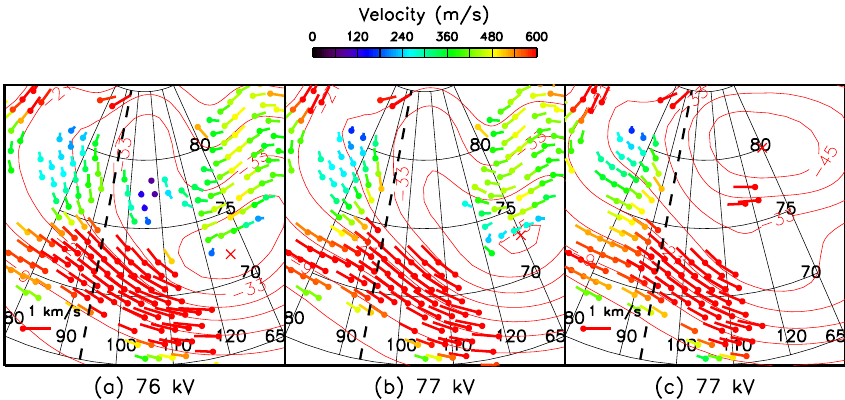
Fig. 14. Comparison of global convection map features in the dusk sector in geomagnetic coordinates for the interval 13:32–13:34 UT on 11 February 1998, representing (a) default processing, (b) velocity-range gate filtering to remove ground backscatter, and (c) velocity-range gate filtering to remove both ground and far-range E-region backscatter. The arrows represent the flow determined from the global convection mapping solution at grid points where data were entered. The solid (dashed), red lines represent equipotentials of the estimated convection electric field for the afternoon (morning) convection cell. The bold, dashed line represents the location of